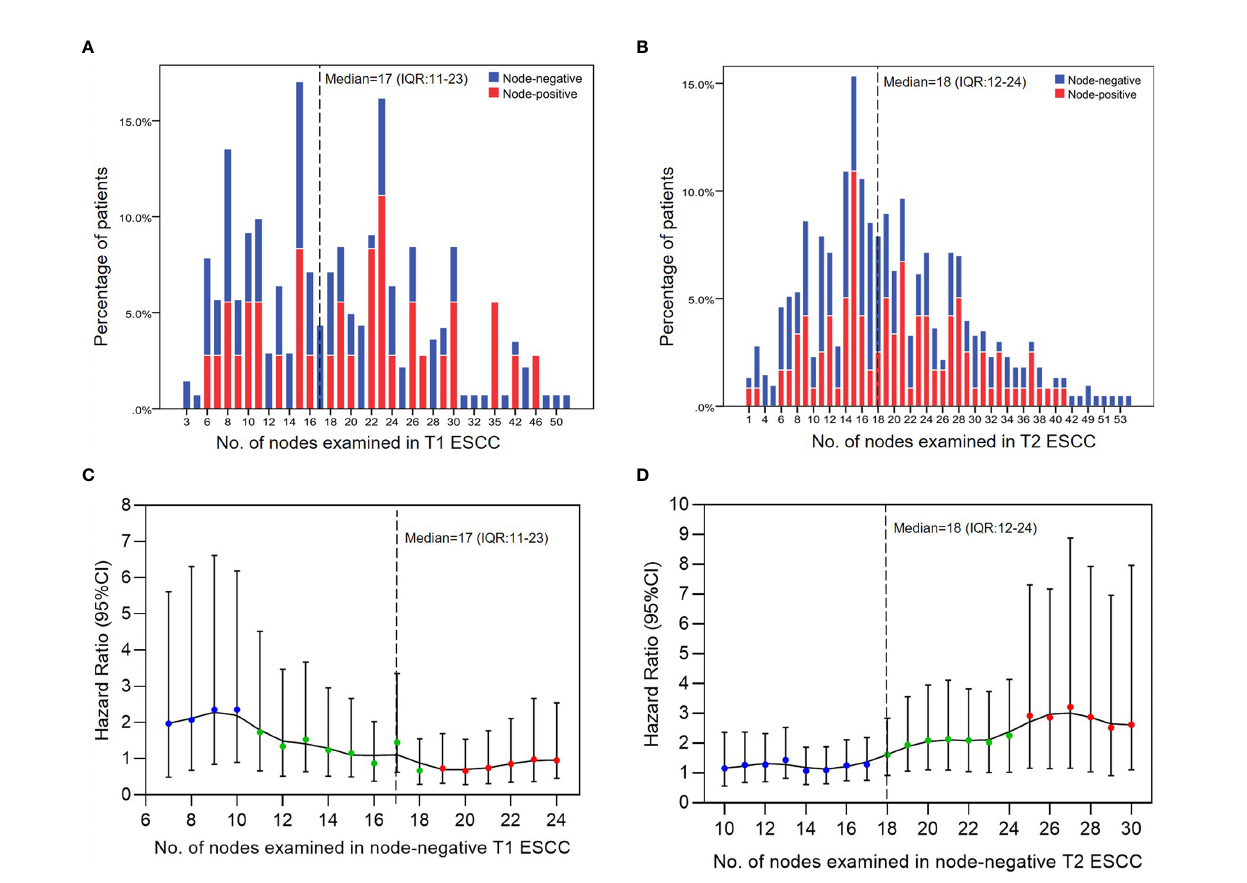
FIGURE 2 | (A, B) The distribution of positive and negative fi ndings associated with the number of nodes examined. (C, D) Survival hazard analysis based on multiple cut-off points of examined lymph nodes in node-negative ESCC. Hazard ratio represents the survival hazards on the left-side panel of cut-off point compared to the right-side panel of cut-off